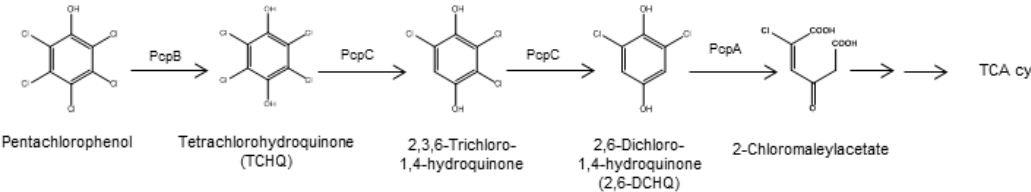
Figure 1. Bacterial degradation pathway of pentachlorophenol (PCP) in Sphingobium chlorophenolicum L-1. PcpB, PCP-4-monooxygenase; PcpC, tetrachlorohydroquinone (TCHQ) reductive dehalogenase;